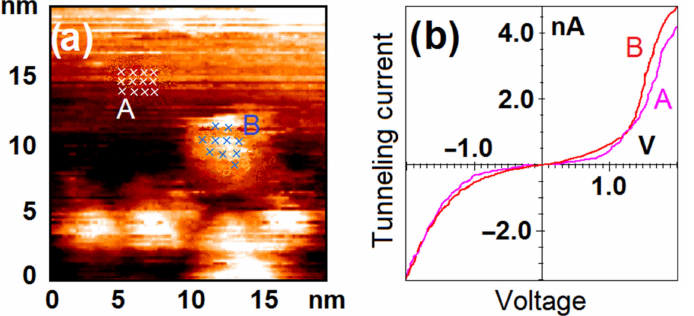
Figure 2. The sample after calcination under UHV conditions. Results of the STM/STS measurement: ( a ) topography image of HOPG surface with deposited clusters of Ni nanoparticles; ( b ) VAC curves of the tunneling currents averaged over the set of points on the surface of nanoparticles (red curve B) and HOPG (pink curve A) marked with crosses in ( a